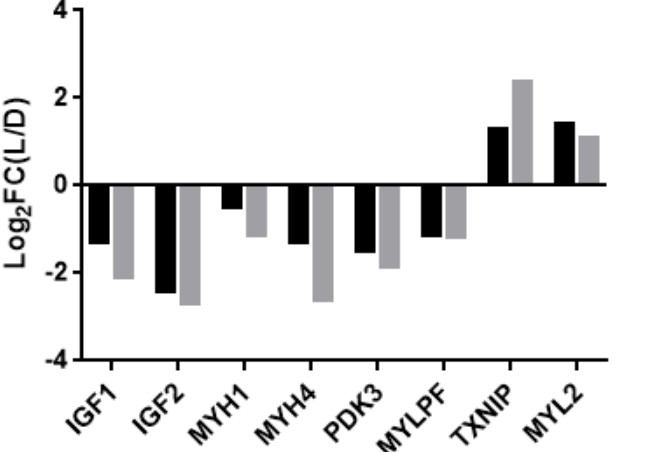
eight genes were consistent with the RNA-Seq data. These results suggest that the RNA-Seq data are credible and can be used for subsequent experiments. This finding suggests that the identified DEGs play major roles in affecting the meat quality and growth rate of Duroc and Luchuan pigs.